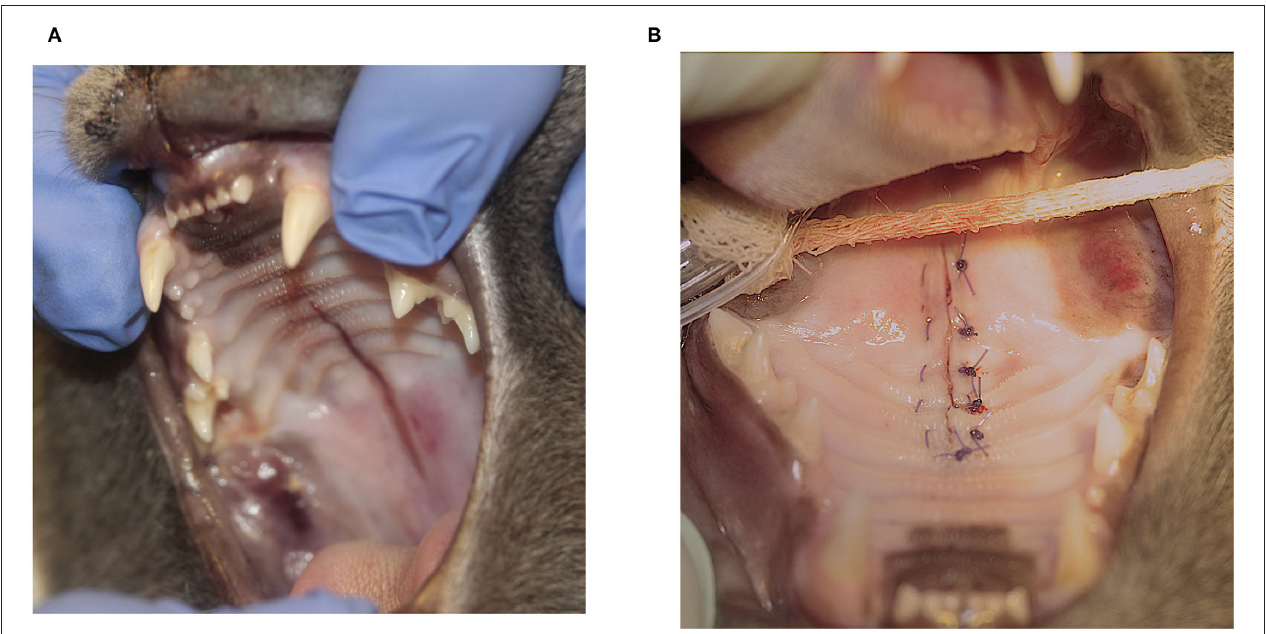
FIGURE 2 | Direct apposition of the mucoperiosteal edges without releasing incisions. (A) Acquired midline palate defect (PDE) extending from the level of the mesial aspect of the maxillary third premolar teeth to the rostral aspect of the soft palate. (B) Direct apposition of the mucoperiosteal tissue edges in a horizontal mattress suture pattern.